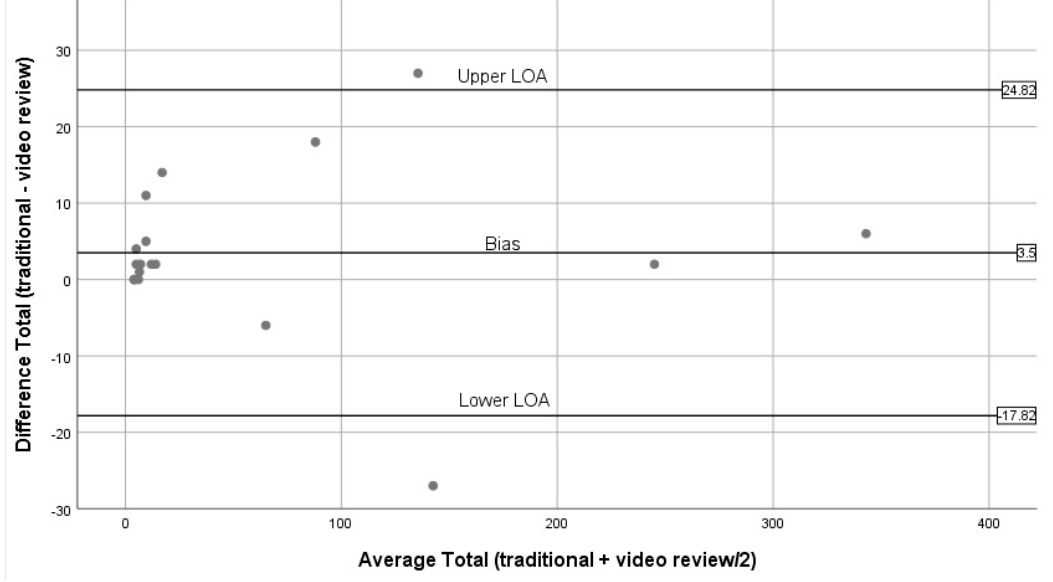
Figure 4: Bland–Altman plots for total (traditional BWM vs. expert review of BWM videos). Figure 4. Bland–Altman plots for total (traditional BWM vs. expert review of BWM